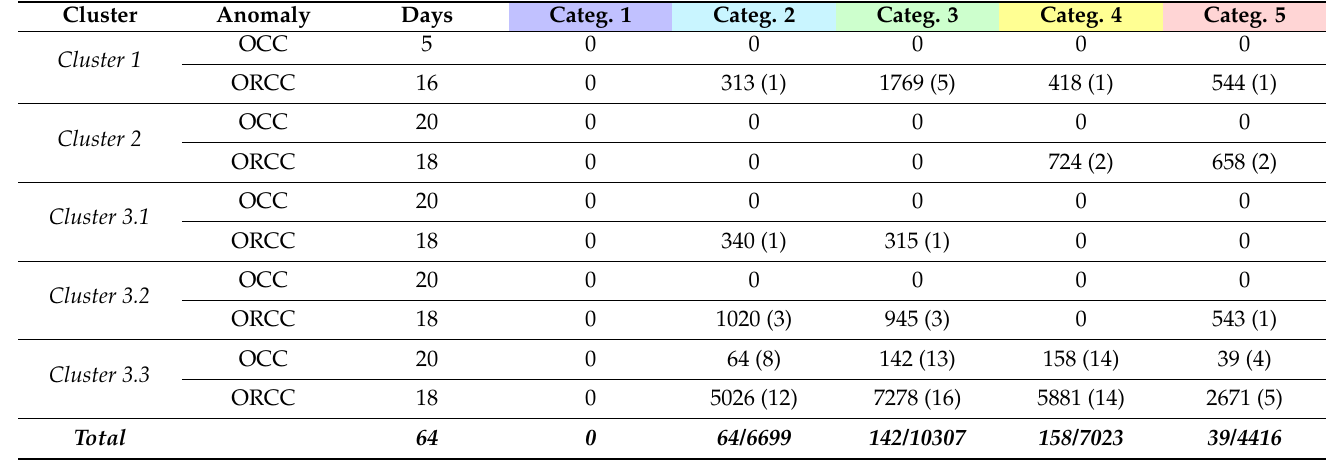
Table 8. Stop points and minutes for OCC and ORCC anomalies vs. EE category. Each EE Category is associated with a color as depicted in Figure